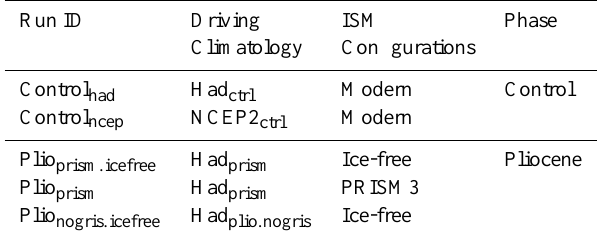
Table 1. Experiments for PLISMIP follow Control and Pliocene Phases. Forcing climatologies are from HadAM3 GCM control and NCEP re-analysis data (see Sect. 2.1). ISM simulations are initiated with modern, PRISM3 ice sheet configurations (Hill, 2009) and ice- free conditions with respective topographies. The ice-free scenarios use isostatically rebounded topography on